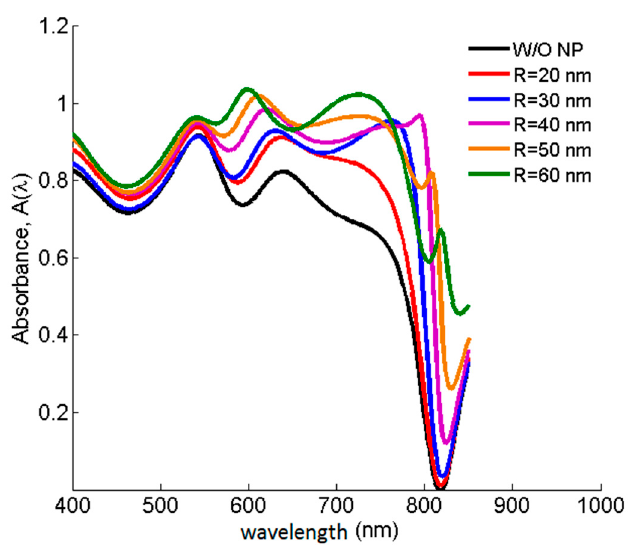
Figure 2. The absorbance spectra of the perovskite layer with different Au nanoparticle radii (the black curve shows the absorbance spectrum of the reference cell).